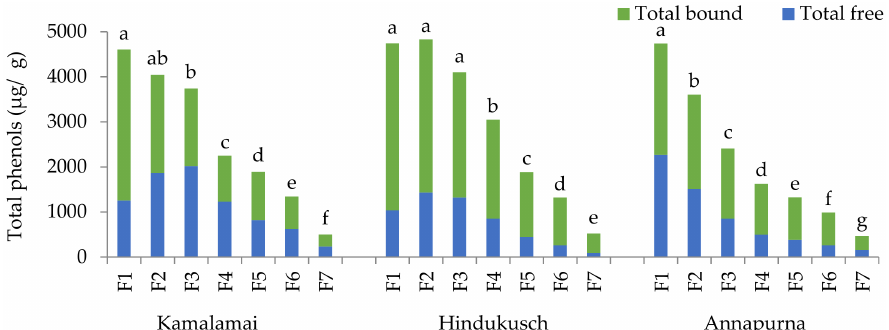
Figure 4. Total phenols contents ( µ g/g) in seven pearling fractions of three food barley genotypes. Results are presented as the mean; different letters indicate significant differences between pearled fractions of each genotype on log-transformed data; (Tukey-Kramer’s HSD for α =